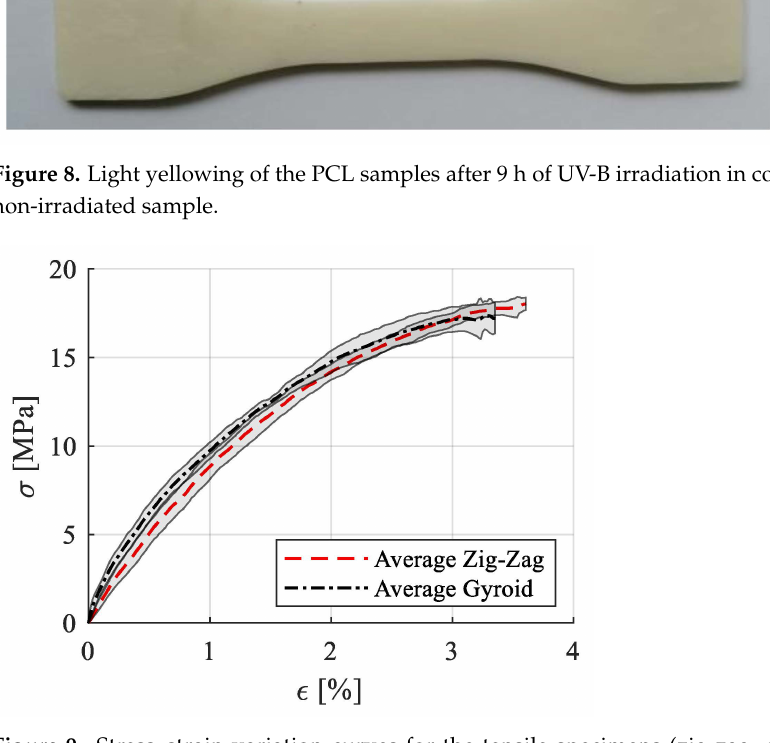
Figure 9. Stress–strain variation curves for the tensile specimens (zig-zag, gyroid, zig-zag after UV-B exposure). Table 3. Mechanical properties of PCL